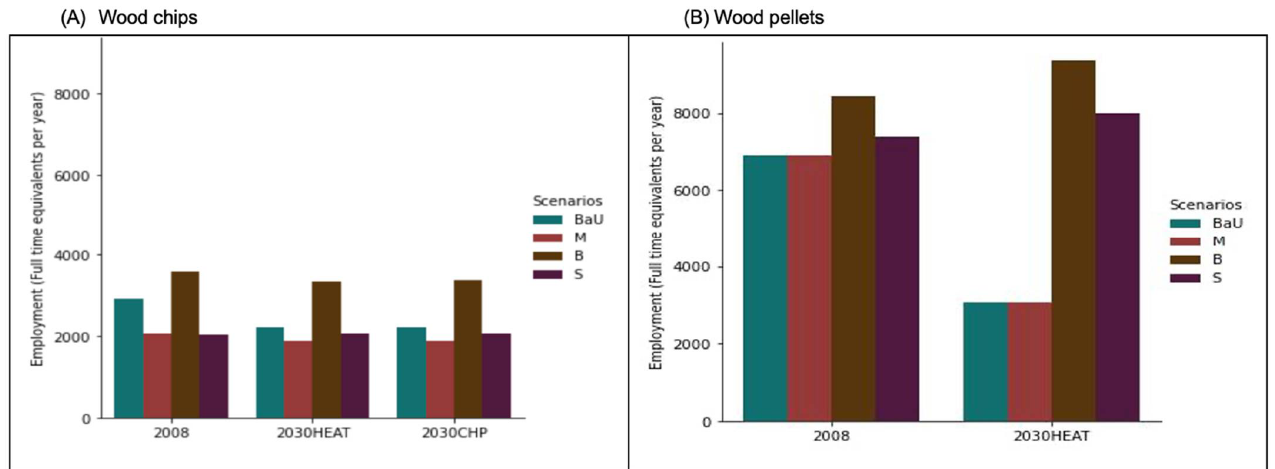
Figure 6. Employment levels for wood chip ( A ) and wood pellet ( B ) value chain scenarios, expressed in full-time equivalents per year.